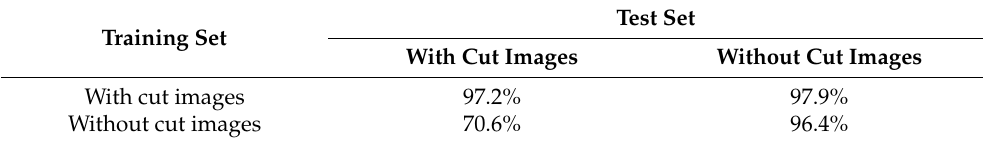
Table 1. Effect of image division in the training set on the accuracy of the multi-slice tensor model.